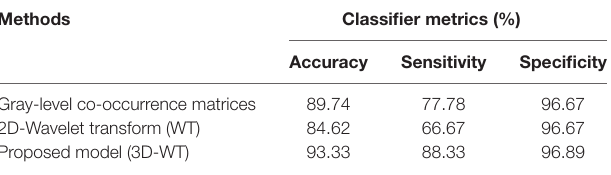
TaBle 3 | Comparative analysis of the proposed